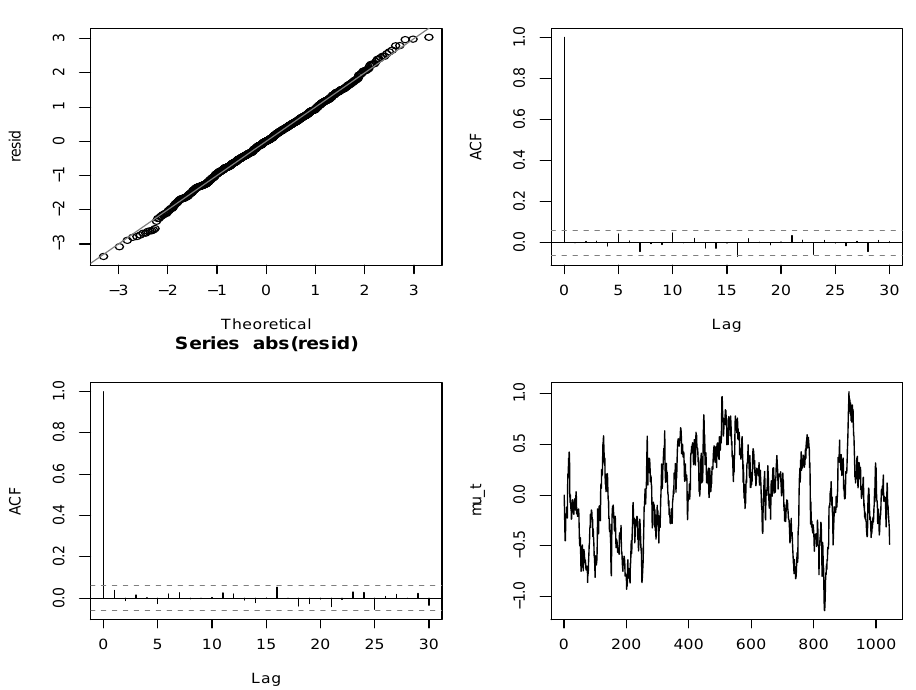
Figure 5. Plots for a VT(2)-ARMA(1,1) model fitted to the Bitcoin return data: QQplot of the residuals against normal ( upper left ); acf of the residuals ( upper right ); acf of the absolute residuals ( lower left ); estimated conditional mean process ( µ t ) ( lower right